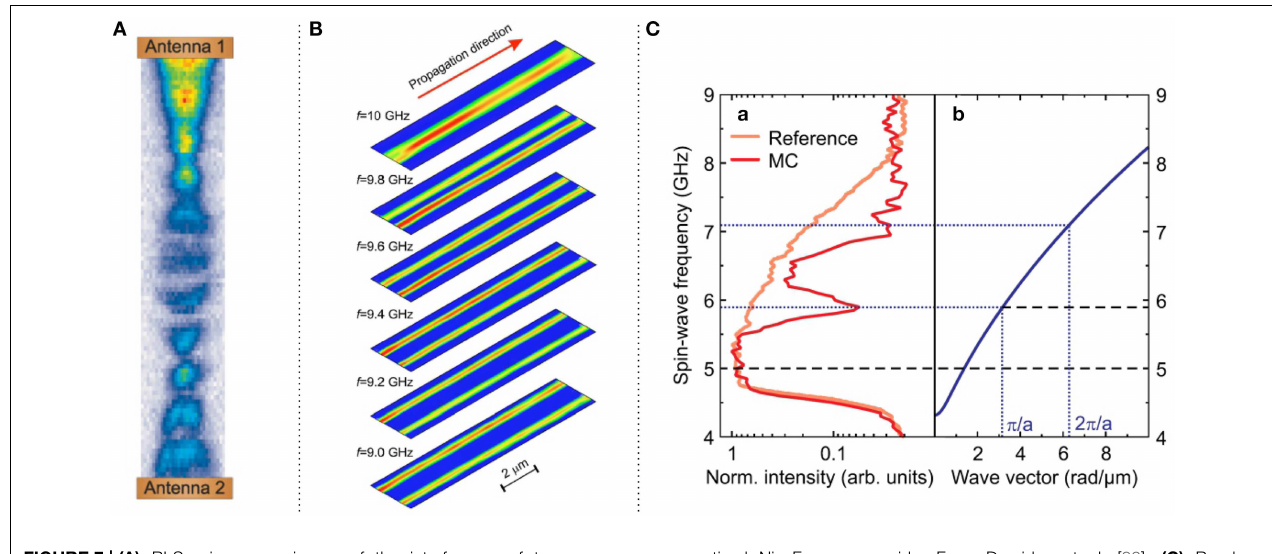
magnetized Ni 81 Fe 19 waveguide. From Demidov et al. [83]. (C) Band gaps in the spin-wave spectrum of a nano-structured magnonic crystal as a function of the magnetic field, taken from Obry et al.